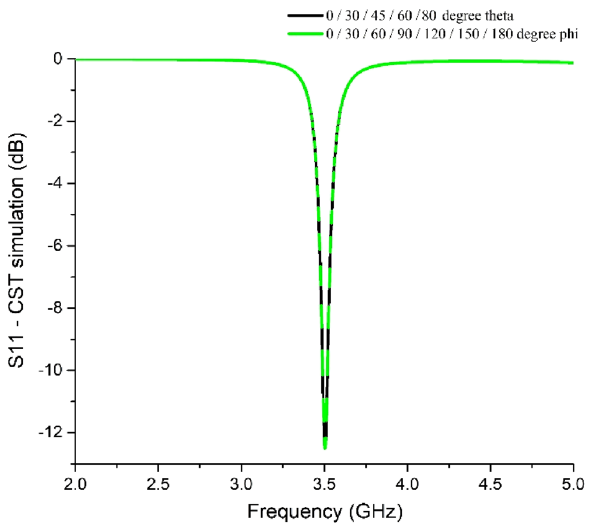
Figure 6. S 11 parameter values for incident EM waves at different normal (theta polarization) and oblique (phi polarization) incidences.